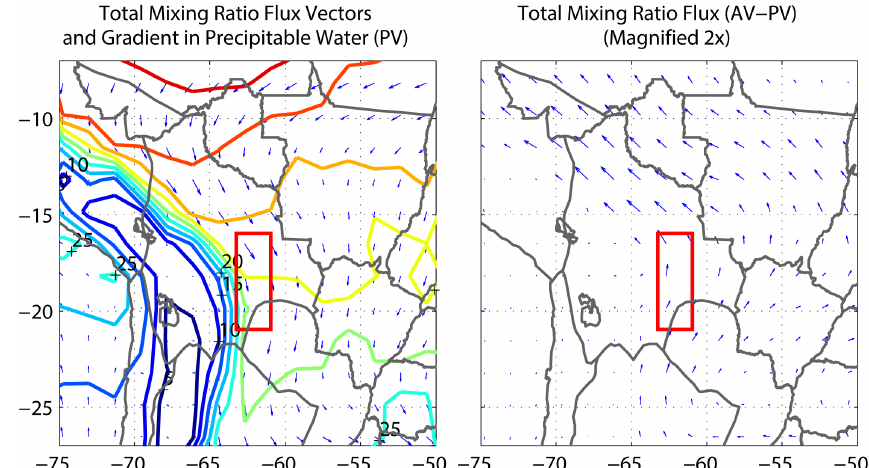
Figure 16. Left panel: map of vertically integrated total water advective flux vectors (quivers) and vertically integrated precipitable water (contours) for the potential vegetation case (PV), region near the Gran Chaco site, April 2003. Quivers are scaled and convey only direc- tionality and relative magnitude. Contours of low precipitable water are shown by cool colors (blues) and high precipitable water with warm colors (reds). Right panel: the differential in vertically integrated advection of total precipitable water, actual vegetation minus potential vegetation (AV–PV). Quivers are scaled to 2 times relative to the left panel. In both panels the sub-domain bounding the Gran Chaco focus region is shown with a red